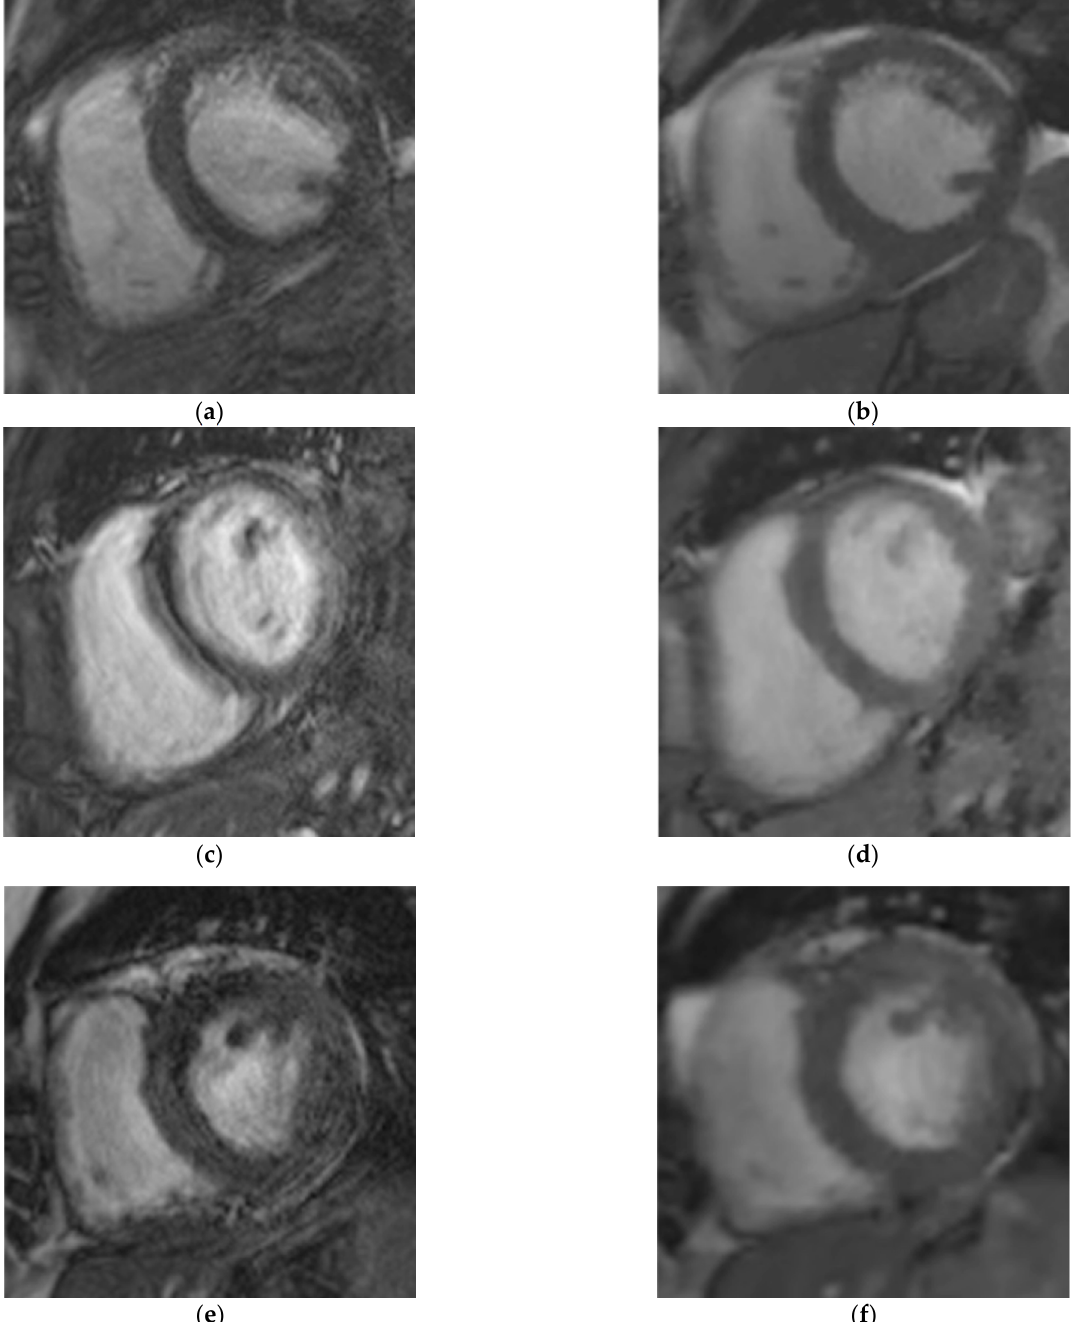
( d ) Likert scale = 3/4, EuroCMR score = 1/10, ε CSrt = 0.050 pixel − 1 ; ( e ) Likert scale = 1/4, EuroCMR score = 3/10, ε Cineref = 3/4, EuroCMR score = 0/10, ε CSrt = 0.035 pixel − 1 . Abbreviations: Cine ref , reference segmented cine; CS rt , real-time com-